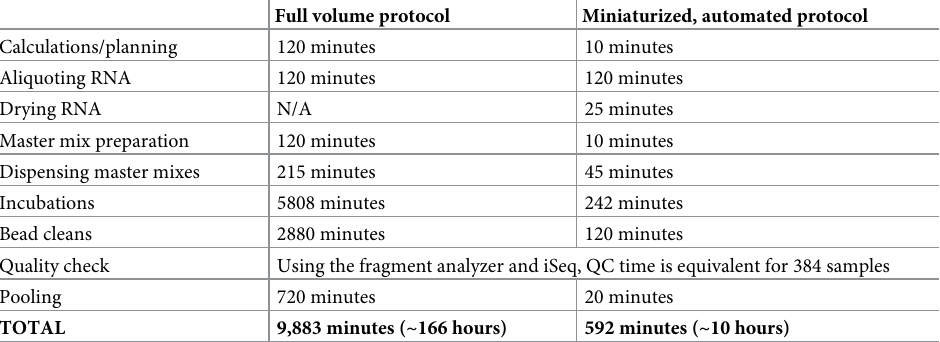
Table 3. Comparison of time at the bench for full-volume and miniaturized protocols for 384 samples.